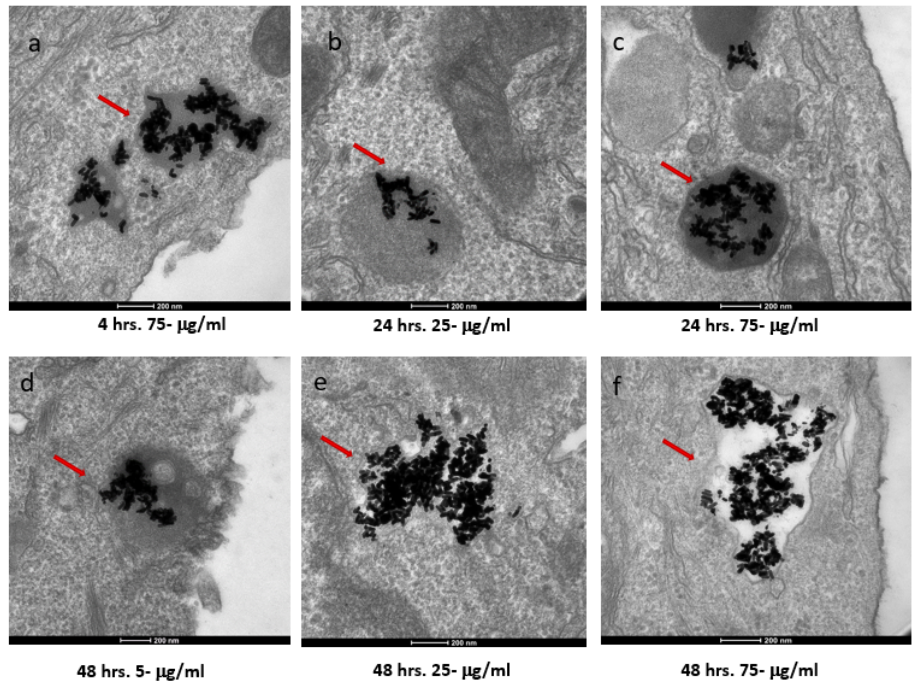
Figure 4. TEM images of AuNRs in SKBR-3 cells at different time points and concentrations. SKBR-3 cells were treated with 5, 25, and 75 µ g/mL of AuNRs for 1, 4, 24, and 48 h. Internalization of nanorods was observed starting at 4 h incubation with 75 µ g/mL ( a ). After 24 h of incubation, internalization was observed with the 25 µ g/mL ( b ) and 75 µ g/mL concentrations ( c ). For cells incubated for 48 h, we observed internalization with 5, 25, and 75 µ g/mL concentrations ( d , e , and f , respectively). Red arrows point to gold nanorods localized in SKBR-3 cells. Electron photomicrographs shown are representative of at least three independent experiments with similar conditions.